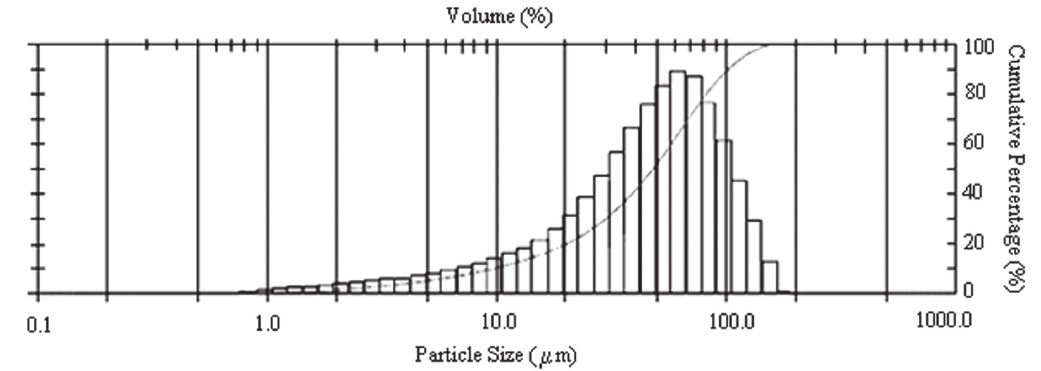
Fig. 2 - Percent distribution of the granite powder